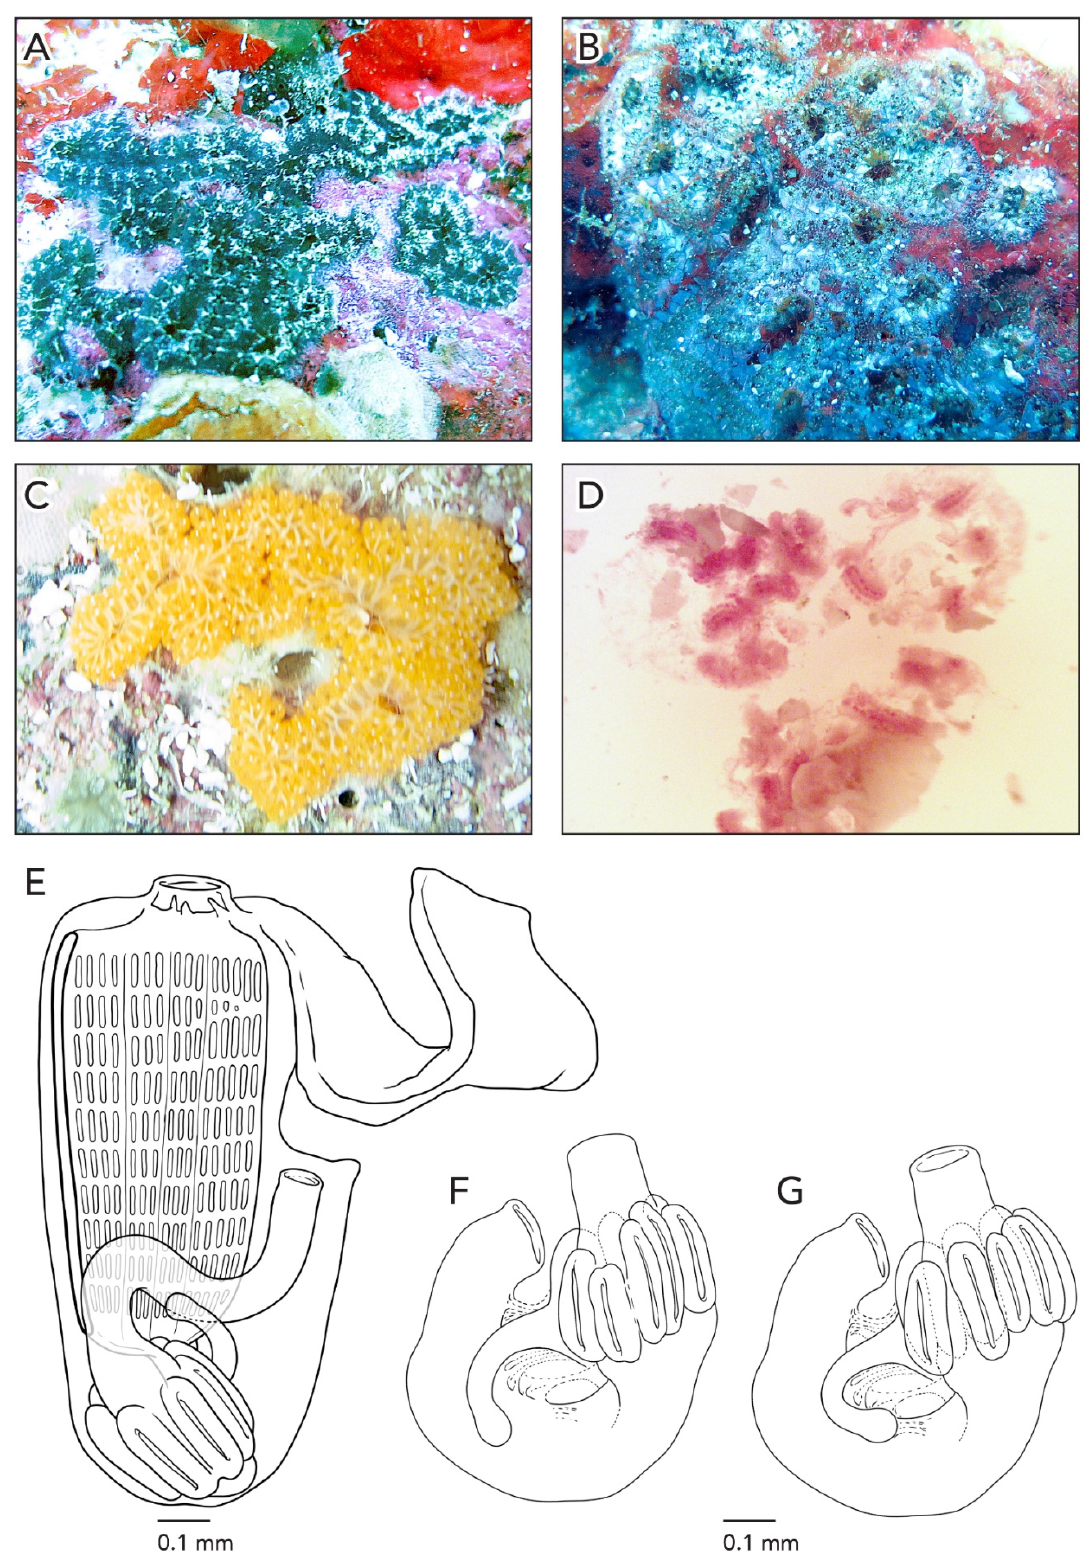
Figure 10. Botryllus unamensis sp. nov. ( A – C ) Live colonies on natural substrate (Dead coral) ( D ) Detail of a preserved colony showing dark spots on both sides of the endostyle ( E ) Left side view of a zooid ( F , G ) Detail of abdomen: variation of the stomach and caecum.